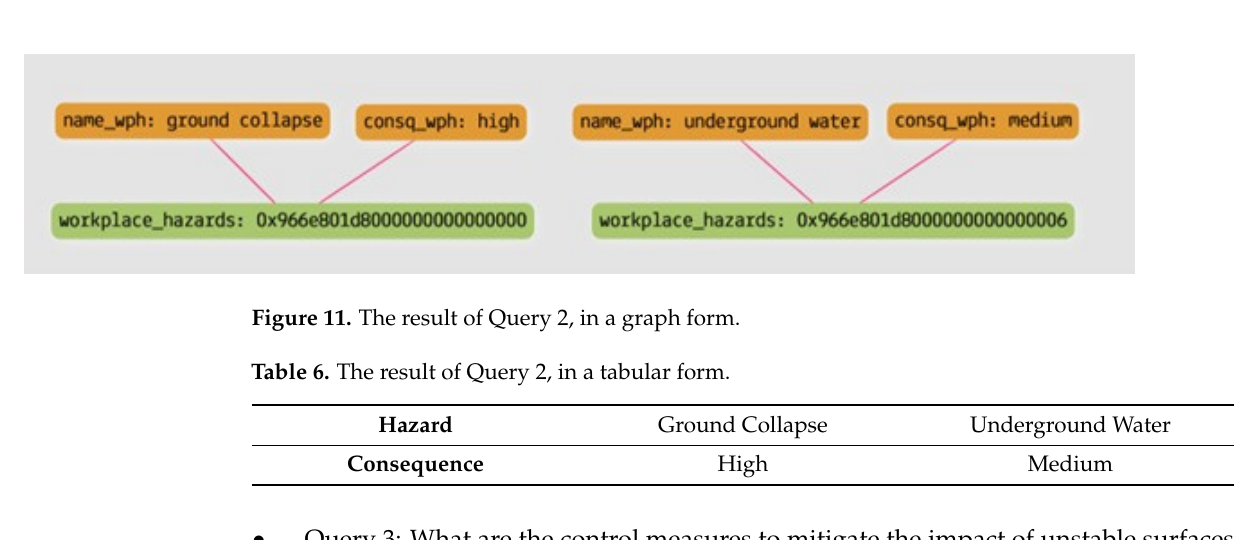
20 of 25 Figure 10. The result of Query 1, in a graph form. Table 5. The result of Query 1, in a tabular form. Hazard